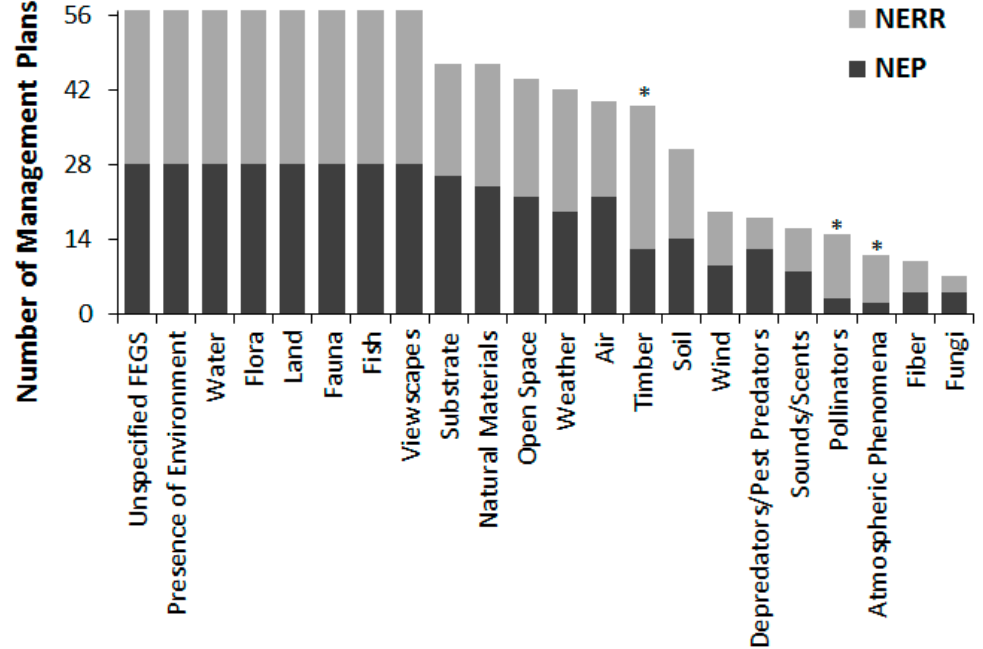
Figure 3. Number of NEP or NERR management plans mentioning each FEGS type. Asterisks denote categories for which counts differed significantly (logistic regression; p < 0.05) between NEP and NERR.